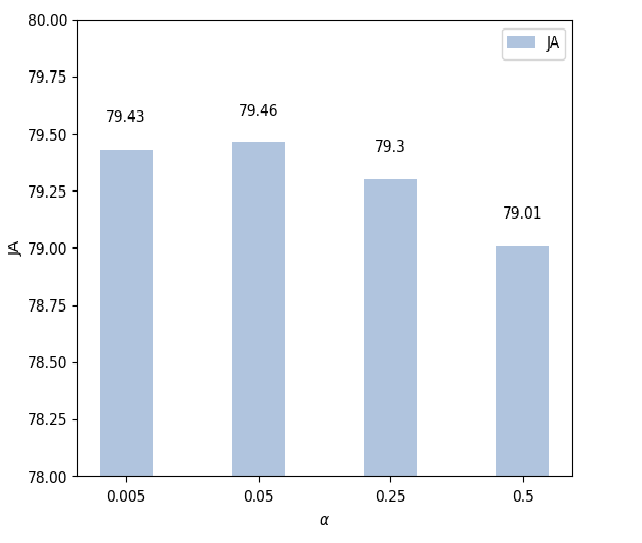
Figure 5. Experiment results with different values of α on the test